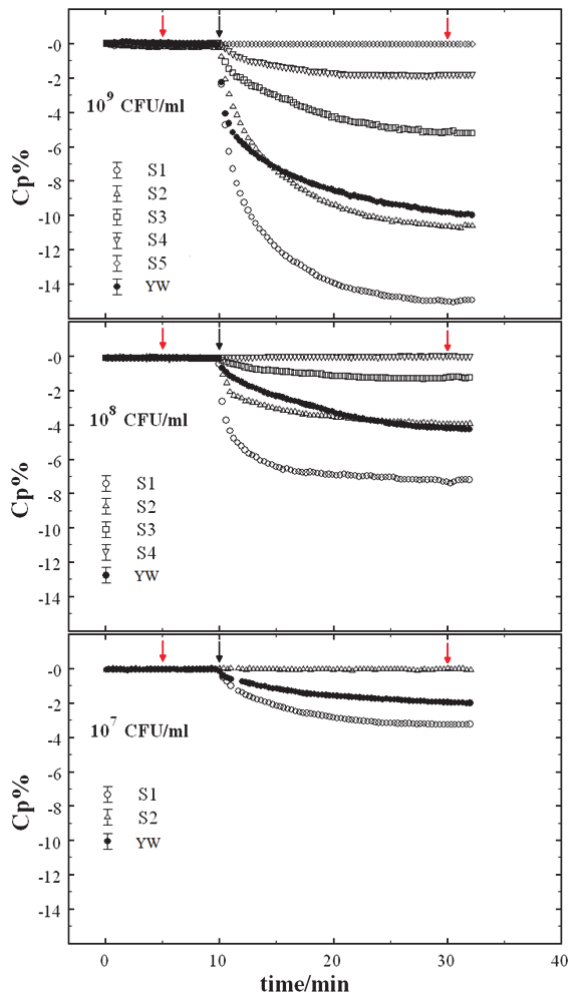
Fig.4: Temporal evolution of C p % for 10 9 ,10 8 and 10 7 CFU/ml. Red arrows indicate the time in which the frequency sweeps were performed. The black arrow indicates the time at which the aggregates of supernatant or YW were made. Overpotential applied: 10 mV at 20